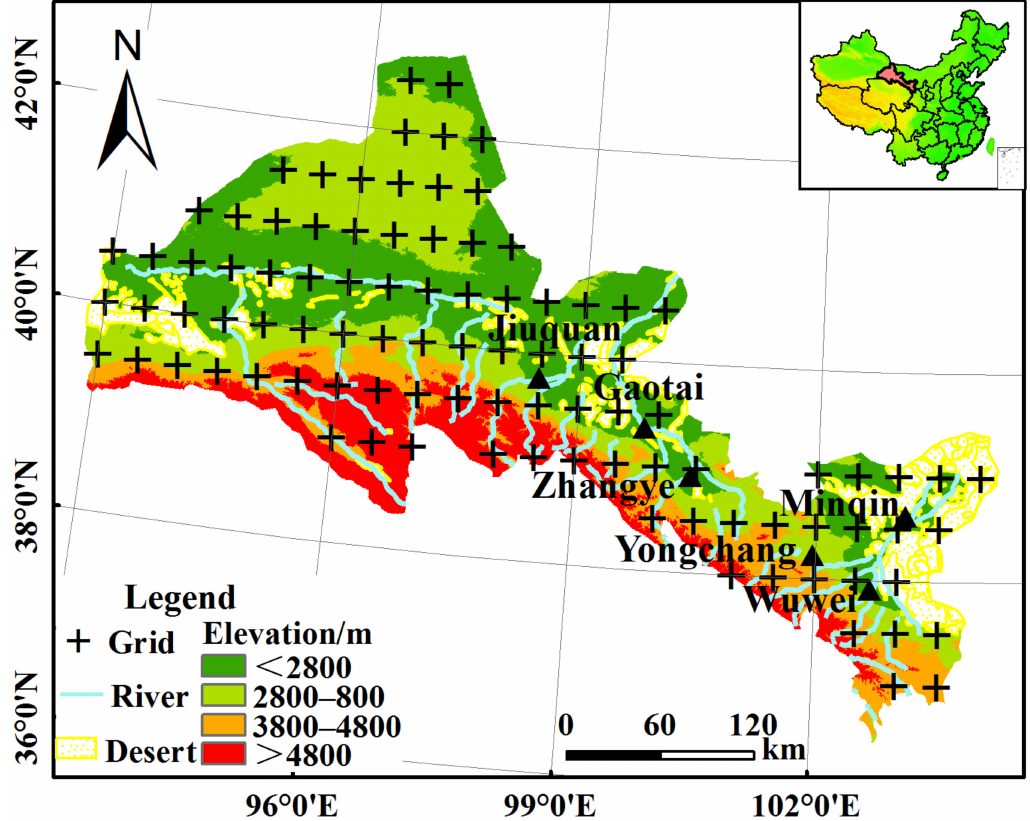
Figure 1. Distribution of the meteorological grids in Hexi